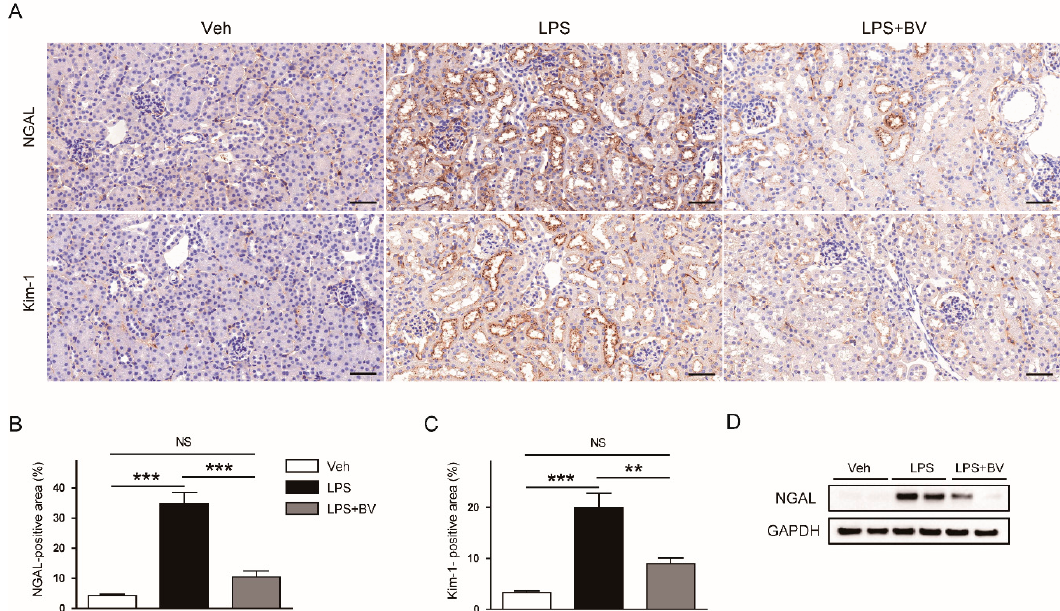
Figure 3. Bee venom attenuated LPS-induced tubular injury. ( A ) Immunohistochemical (IHC) staining of kidney sections using antibodies against neutrophil gelatinase-associated lipocalin (NGAL) or kidney injury molecule-1 (Kim-1). Bar = 100 μ m. ( B ) Percentage of NGAL-positive area. ( C ) Percentage of Kim-1-positive area. ( D ) Representative images of Western blotting of NGAL and glyceraldehyde-3-phosphate dehydrogenase (GAPDH) in kidneys. n = 8 per group. ** p < 0.01 and *** p < 0.001. NS, not significant.